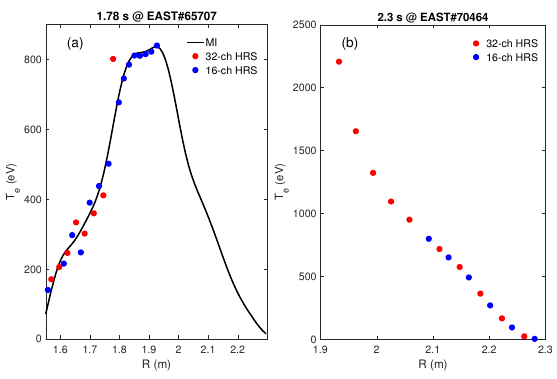
Figure 5. The electron temperature profiles at toroidal magnetic field of 1.80 T (left) and 2.47 T